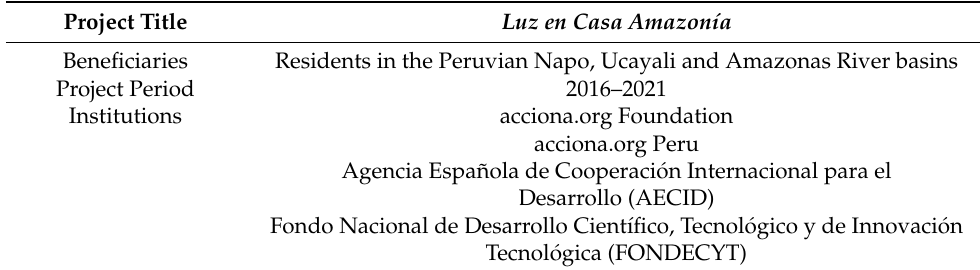
Table 4. “Luz en Casa Amazon í a”: Project